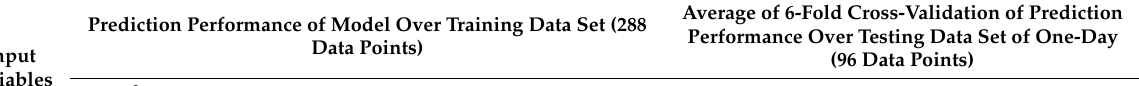
Table 5 . Prediction performance of SVR models of T ahc over training data set of seven days and testing over the next day.